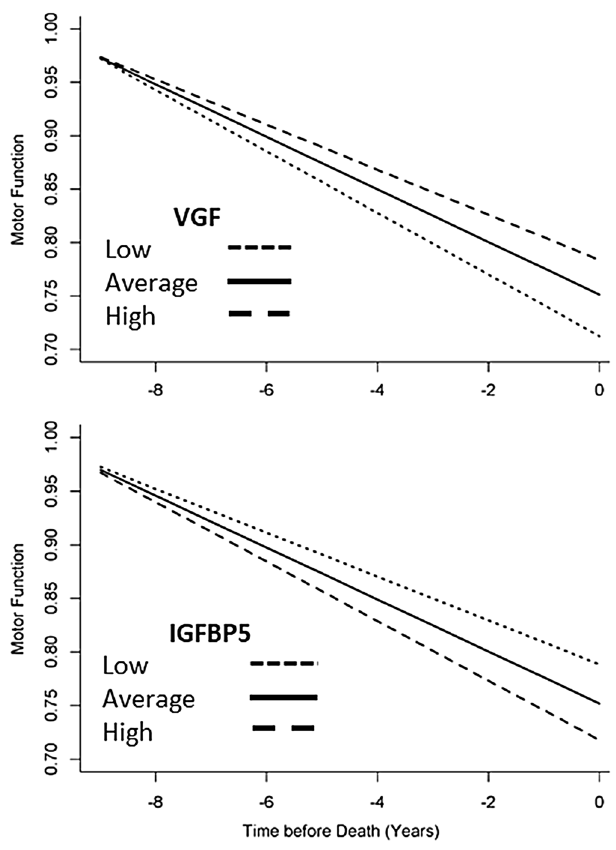
Figure 5. Motor resilience proteins are related of the annual rate of motor decline prior to death in older adults. Figures show model generated trajectories for motor decline for three average participants with low (10th percentile), average (50th percentile) or high (90th percentile) expression levels for VGF or IGFBP5. A higher level of VGF is associated with slower motor decline and a lower level of IGFBP5 is associated with slower motor decline.